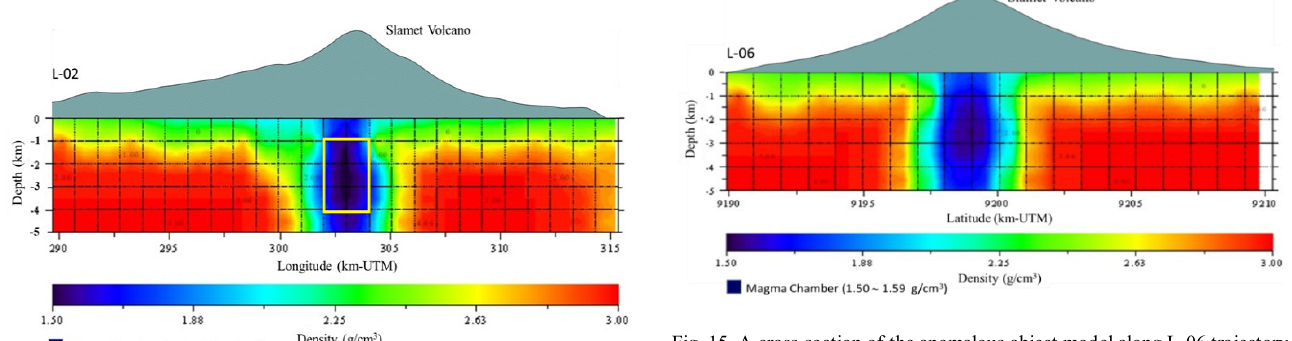
Fig. 15. A cross-section of the anomalous object model along L-06 trajectory at longitude of 302.500